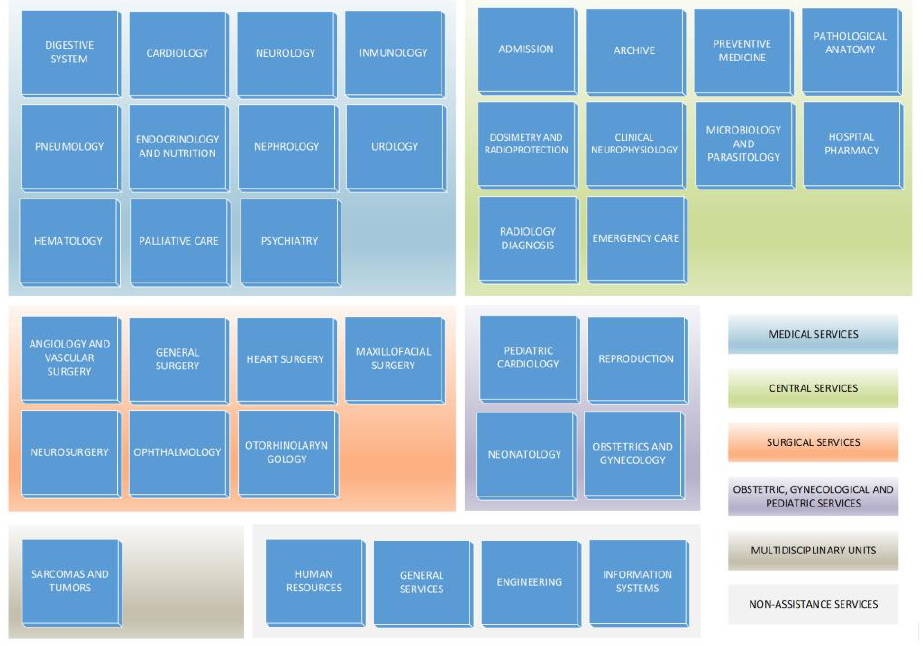
Figure 2. Grouping of clinical specialties in blocks.